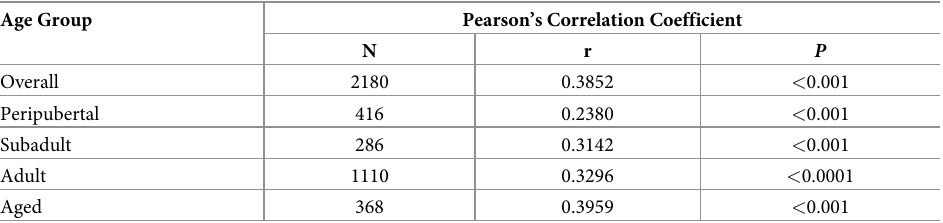
Table 3. Correlations between fecal androgen and glucocorticoid